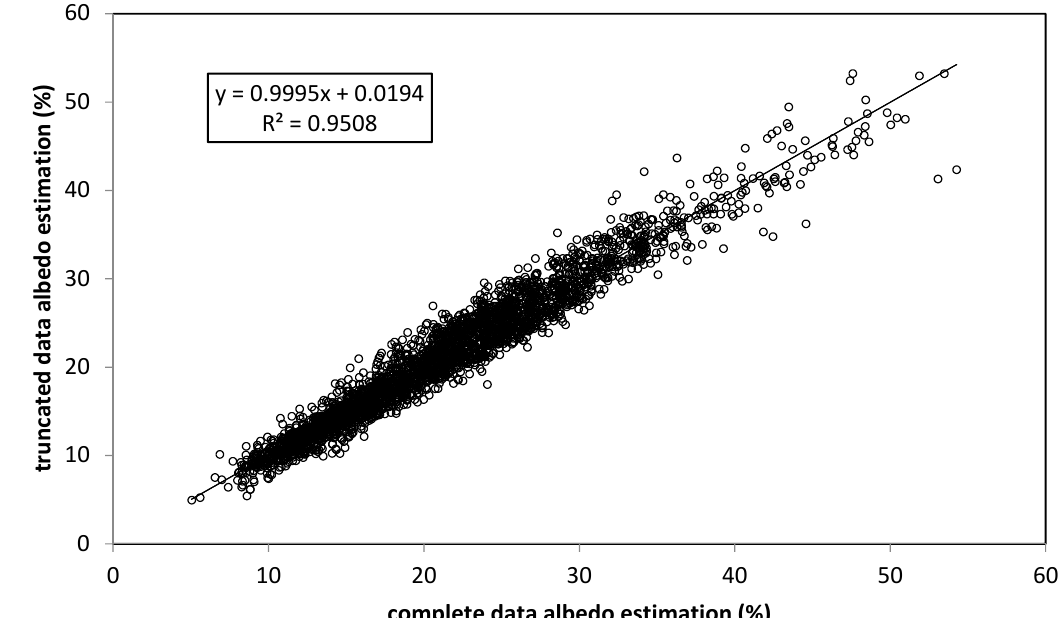
Figure 6. Relationship between albedo values estimated using either all of the spectral bands of the ETM + sensor (complete model) or bands B5 and B7 only (truncated model).